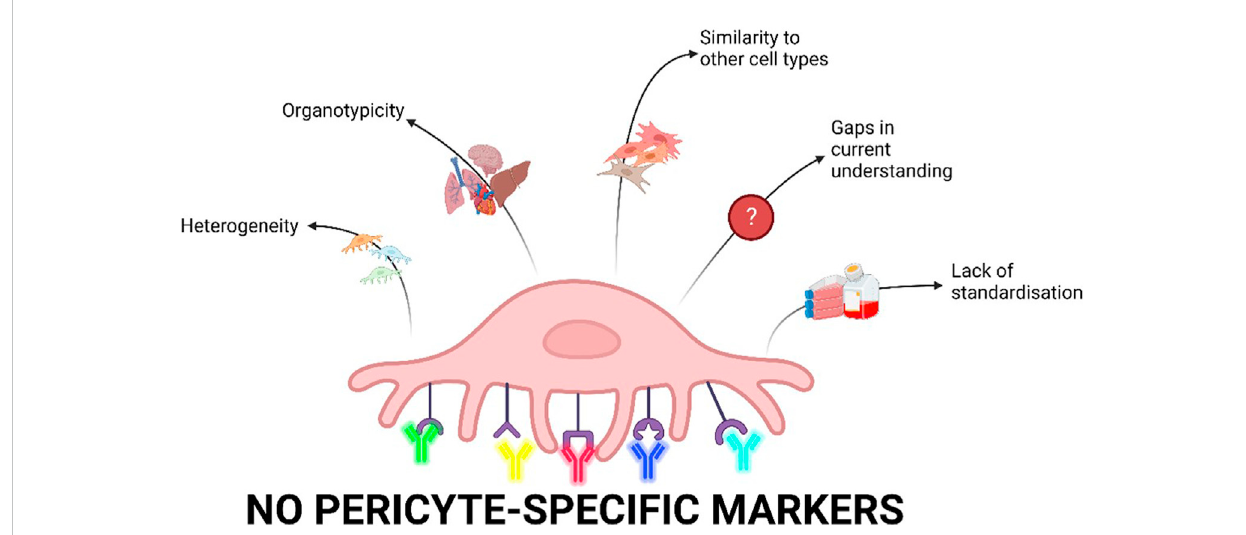
Current limitations of pericyte research. Pericytes are heterogenous depending on their location in the vasculature as well as biological processes and culture conditions. scRNA-seq data have shown major differences in pericytes derived from different organs. Furthermore, pericytes share markers with other cell types including fi broblasts, vascular smooth muscle cells, and mesenchymal cells and are therefore dif fi cult to distinguish. Our current understanding of pericytes is limited as there are gaps in the research on pericyte physiology and pathophysiology. Finally, there is a lack of standardisation of isolation, characterisation, and cell culture conditions for pericytes which is ultimately driven by a lack of pericyte-speci fi c markers (Created with